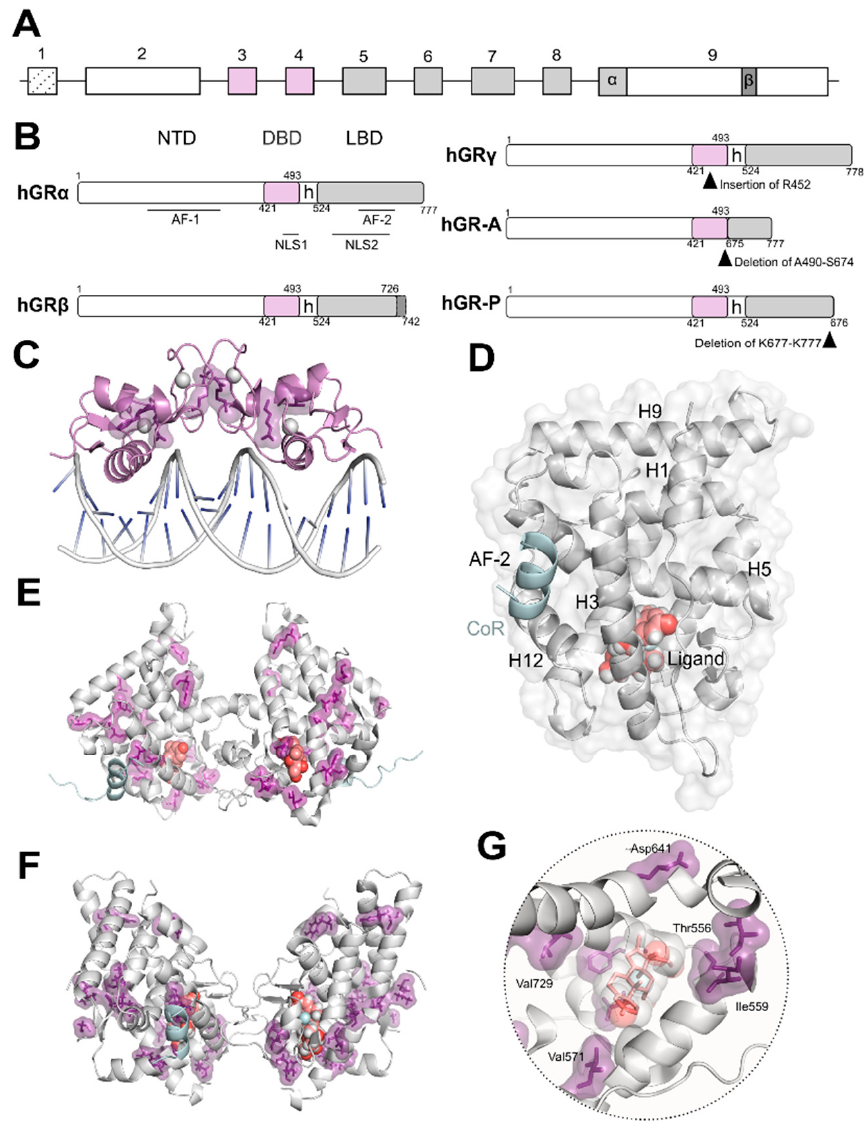
Figure 1. Glucocorticoid receptor (GR) isoforms: domain organization and crystal structures. ( A ) Schematic representation of NR3C1/GR gene organization. A unique gene gives rise to several isoforms through alternative splicing ( B ) and/or alternative transcription initiation. The exons encoding for the modular domains: N-terminal domain (NTD), DNA-binding domain (DBD), and ligand-binding domain (LBD), are indicated; exon 9 encodes the two alternative C-termini of the LBD in GR α and GR β . ( B ) Schematic representation of GR isoforms domain organization generated by alternative splicing. hGR α modular domains include the intrinsically disordered NTD harboring the ligand-independent activation function (AF)-1; the DBD, the most conserved along the nuclear receptor superfamily; a poorly conserved hinge region (h); and the LBD displaying the surface-exposed co-regulator AF-2 groove. The five splice variants GR α , GR β , GR γ , GR-A, and GR-P are shown; insertion/deletions are indicated by black arrowheads. ( C ) Crystal structure of the GR-DBD dimer bound to DNA shown in grey cartoon (PDB code 5CBX). This domain can dimerize on (+)GRE to activate transcription. Residues implicated in glucocorticoid (GC) resistance are shown (V423, R469, R477, F478) in purple as sticks and surface. The zinc ions are shown as grey spheres. ( D ) Cartoon representation of the three-dimensional secondary structure of the GR-LBD